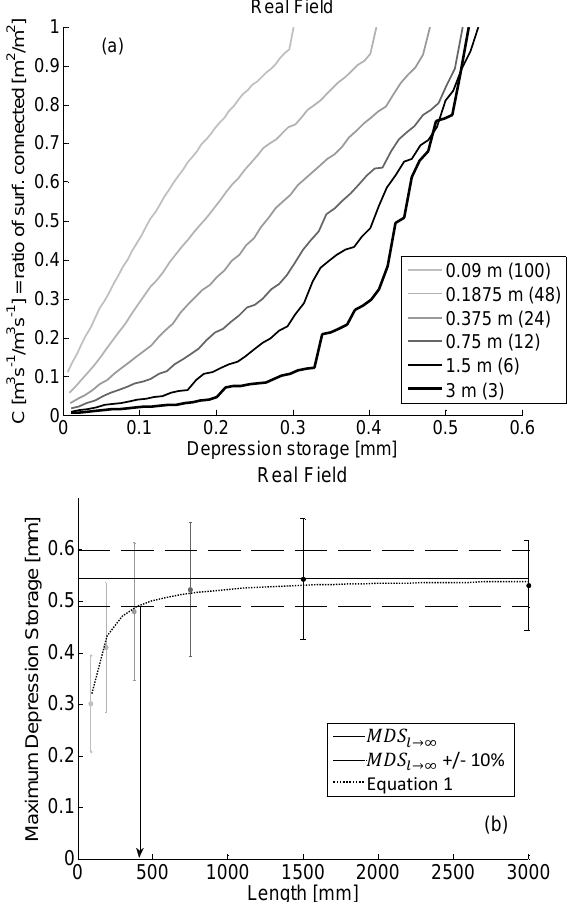
Fig. 6. Real field – effect of plot length on the average RSC function (a) and on the maximum depression storage (MDS) (b) . The numbers in parentheses indicate the number of connectivity curves used for calculating the average RSC functions. Vertical bars = standard deviations. The arrow indicates the representative length. All the plots are 3 m wide.